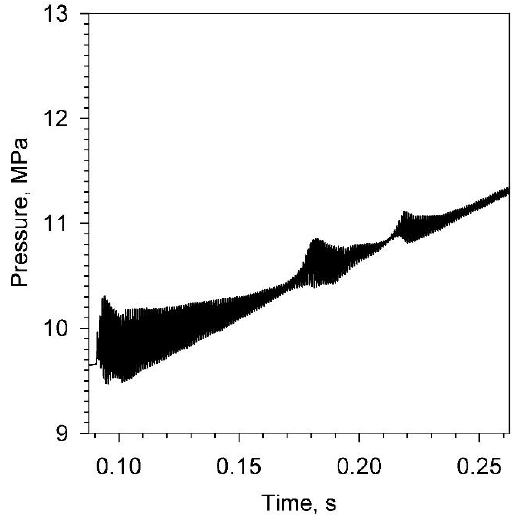
Figure 12. Predicted head-end pressure-time profile, reference motor ( K Δ H = 150,000 J/kg, α = 15%, d = 50 µm; Δ p = 2 atm), single regressing particle set s p m,o d (D 2 law, k = 3.6 × 10 −7 m 2 /s), acceleration r